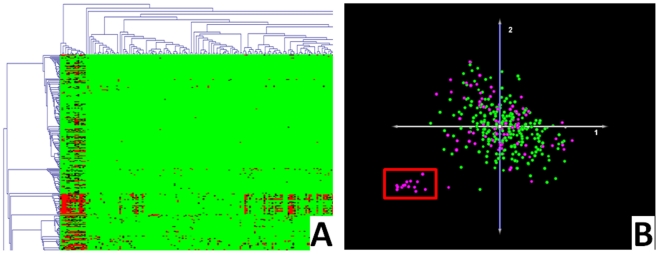
Outlier Group.A group of 14 outliers (red box) is consistently identified with various unsupervised clustering algorithms, including hierarchical clustering (A) and PCA (B). Note: a reproduction of Figure 3G has been used here and is colorized in an identical fashion.